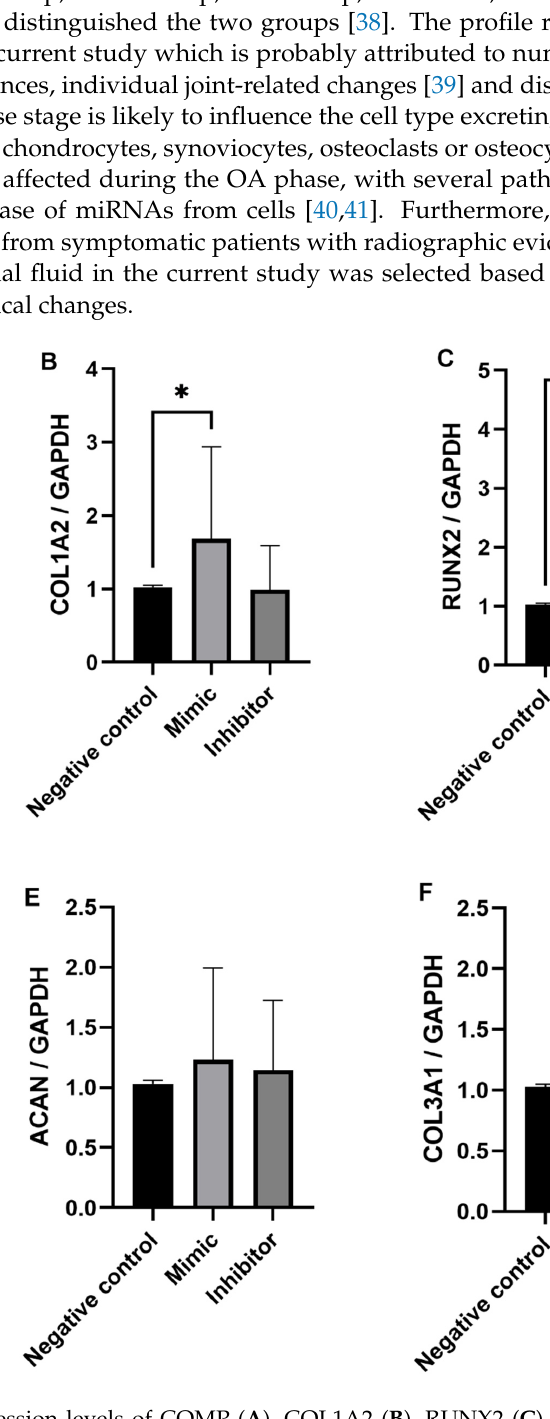
Figure 5. Expression levels of COMP ( A ), COL1A2 ( B ), RUNX2 ( C ), SOX9 ( D ), ACAN ( E ) and COL3A1 ( F ) determined by RT-qPCR with GAPDH as the endogenous control. Data is represented as means ± standard deviations of the three combined biological replicate samples for each treatment measure from each donor ( n = 6). Statistical significance was tested in Graphpad Prism using a Mann–Whitney test. * p < 0.05, ** p <